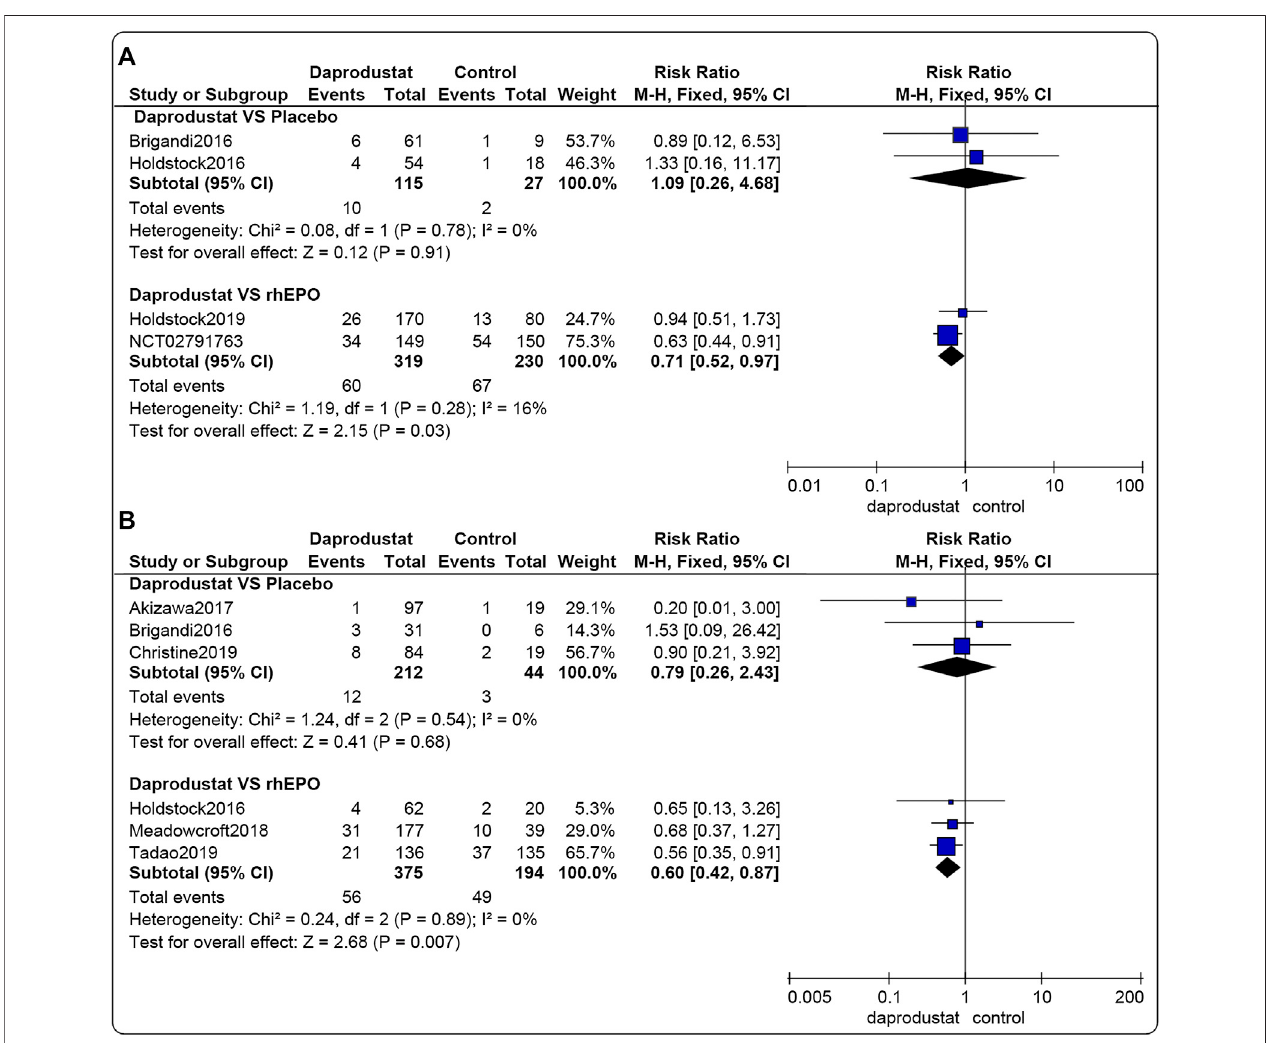
FIGURE 7 | The meta-analysis results of daprodustat for SAEs. (A) The pooled results for NDD patients; (B) The pooled results for DD patients.